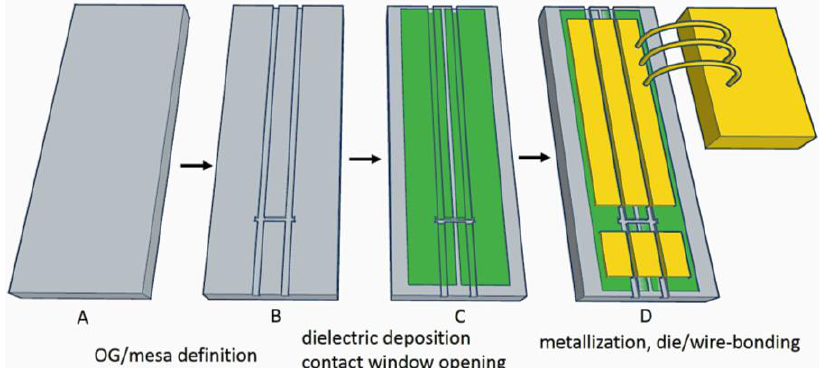
Figure 1. Schematic drawing of the fabrication process for the dry-etched CC-QCL.